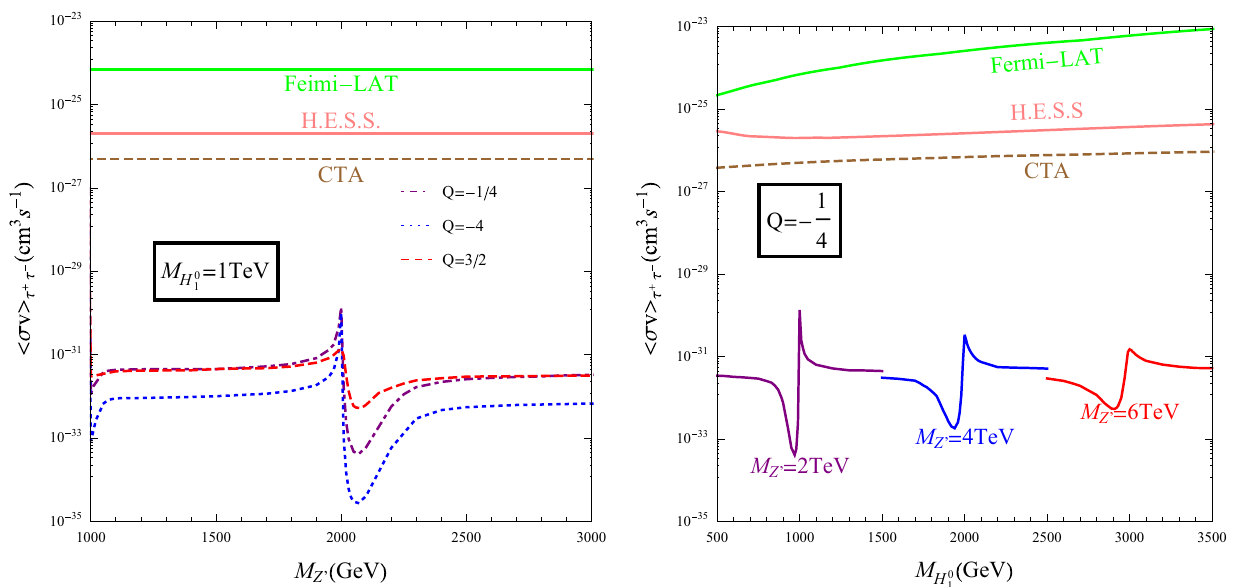
Fig. 10 Annihilation cross section for scalar DM H 0 state. Left: as a function of M Z (cid:2) for M Right: as a function of M